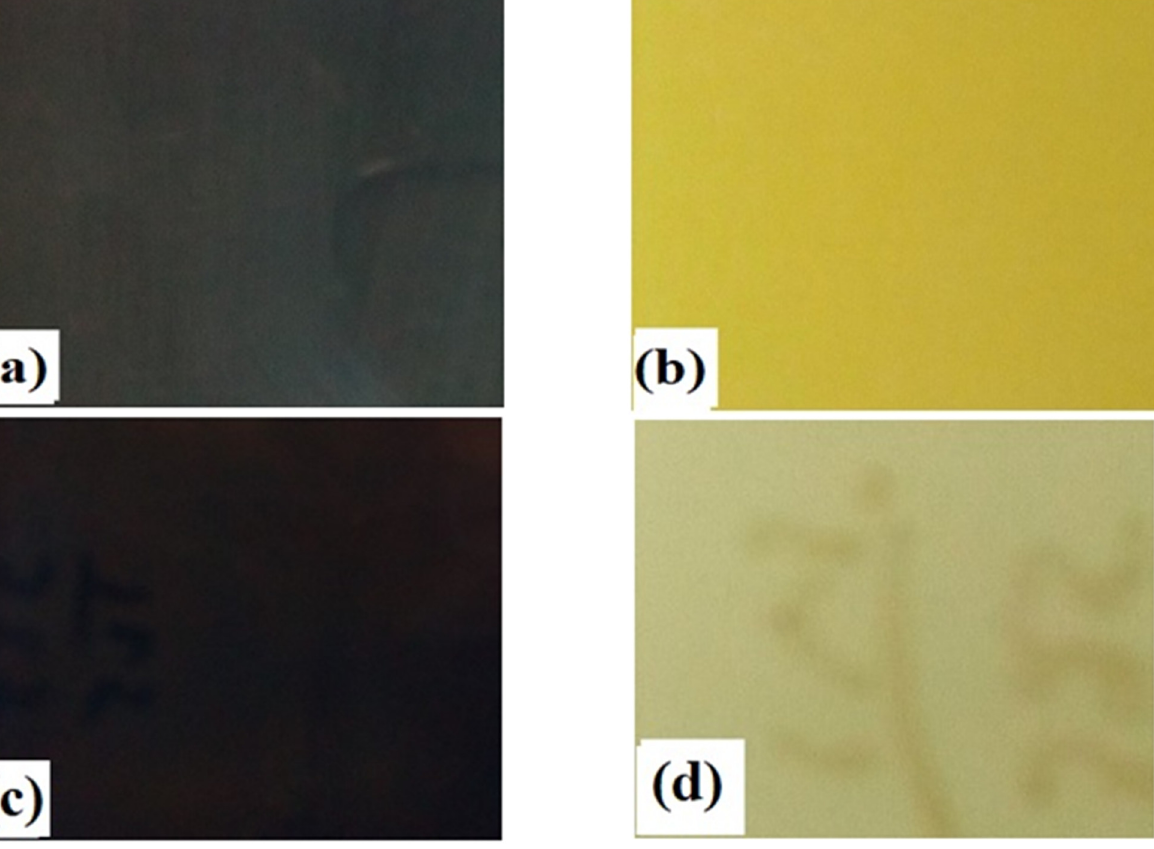
Figure 1. Image of thin films: ( a ) CdO before annealing; ( b ) CdO after annealing; ( c ) Cd 0.75 Mg 0.25 O before annealing; ( d ) Cd 0.75 Mg 0.25 O after annealing.